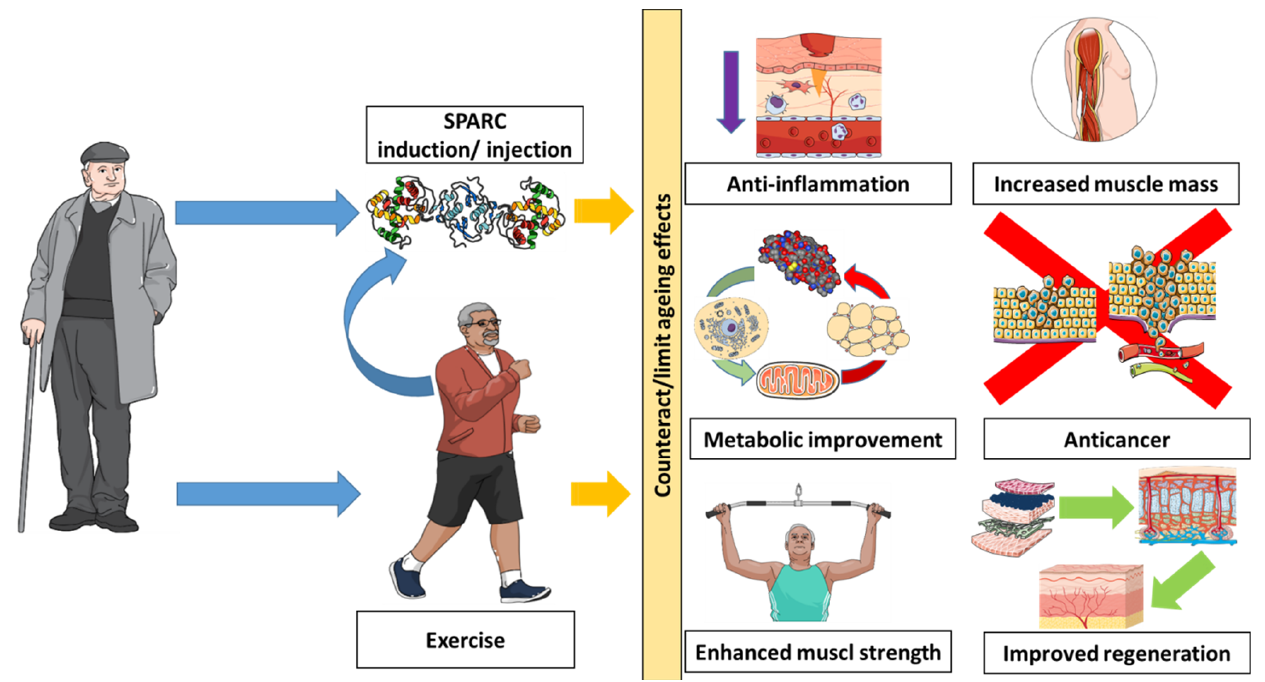
Figure 1. Secreted protein acidic and rich in cysteine (SPARC) as a potential antiageing “exercise substitute”. SPARC (which is induced by exercise) represents a potential therapy that can mimic exercise and produce antiageing effects. This is of particular importance because ageing usually reduces mobility and age-related diseases could also reduce the ability to perform the required physical activity.